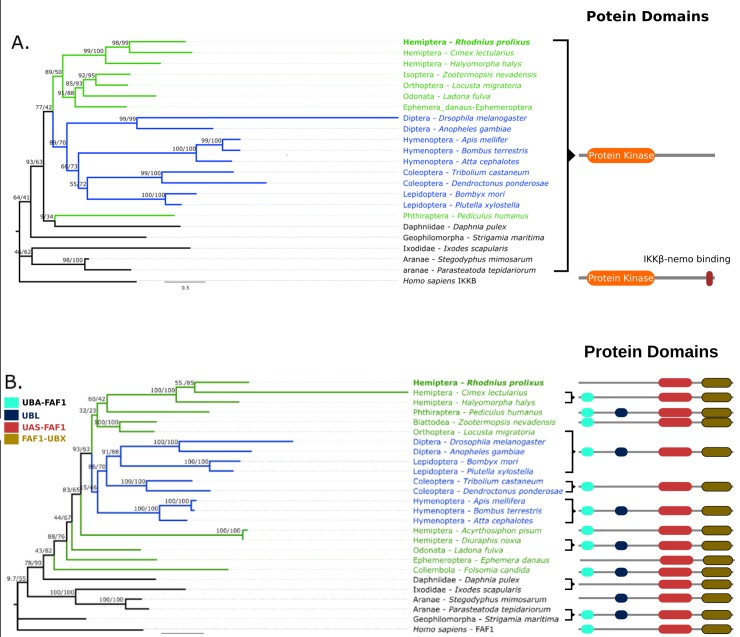
IKKβ and IAP2 Maximum likelihood phylogenetic trees in selected arthropods.(A) rpIKKβ forms a clade with other hemimetabolous insects (except P. humanus) and is a sister clade to all other insects, but different from other arthropod groups. (B) rpIAP2 forms a clade with other hemipterans and is a sister clade to all hymenopterans and coleopterans insects. The human IKKβ ortholog was used as an outgroup to build the ML trees.